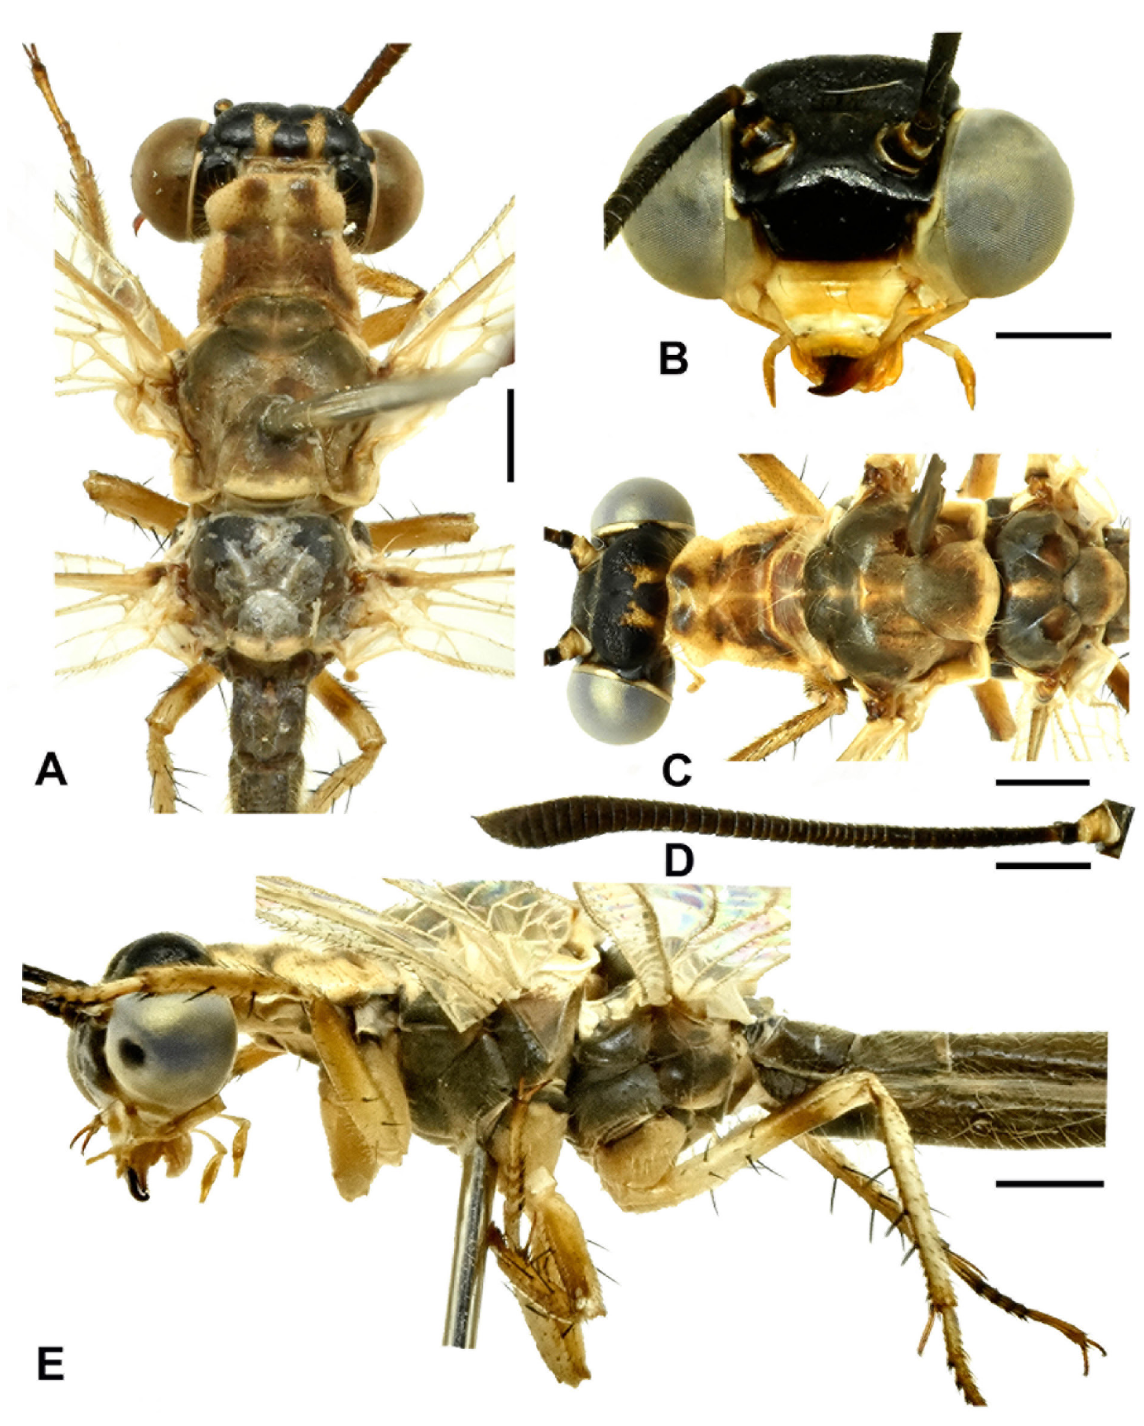
Fig. 8. Myrmeleon tenuipennis Rambur, 1842. A . Dorsal habitus of head and thorax. B . Head, frontal view. C . Head and pronotum, dorsal view. D . Antenna. E . Lateral view. A–B, D–E: ♂ (CAUPK000010); C: ♀ (CAUPK000011). Scale bars: A = 2.0 mm; B–D = 1.0 mm; E = 3.0